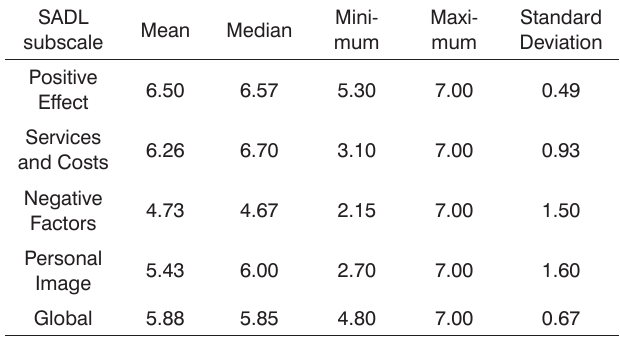
Table 2. Distribution of the mean results between the first and the second application as to the SADL Questionnaire